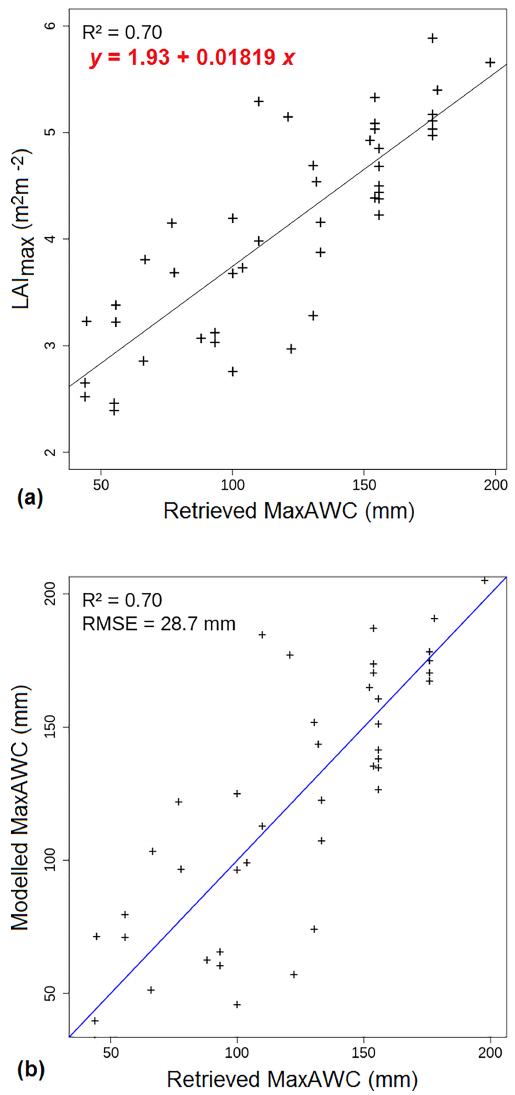
Figure 12. Use of median observed annual maximum of LAI to retrieve MaxAWC for all 45 départements: (a) linear regression relationship between maximum LAI and the LDAS tuning Max- AWC estimates; (b) MaxAWC estimates derived from the statisti- cal model using maximum LAI observations as a predictor vs. the LDAS tuning MaxAWC